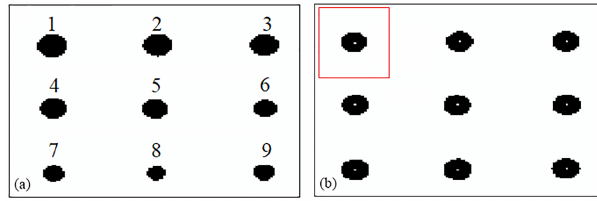
Figure 4. Effect of segmentation after applying RIFC technique with B = 5 and emissivity set to ε = 0 . 98: (a) global thresholding, (b) local thresholding. Table 1. Evaluated horizontal dimension of defects from segmented thermogram with global thresholding, measured in pixels. The val- ues which vary from the real size by not more than 1 pixel, i.e. [12, 13, 14], have been additionally highlighted in bold type.